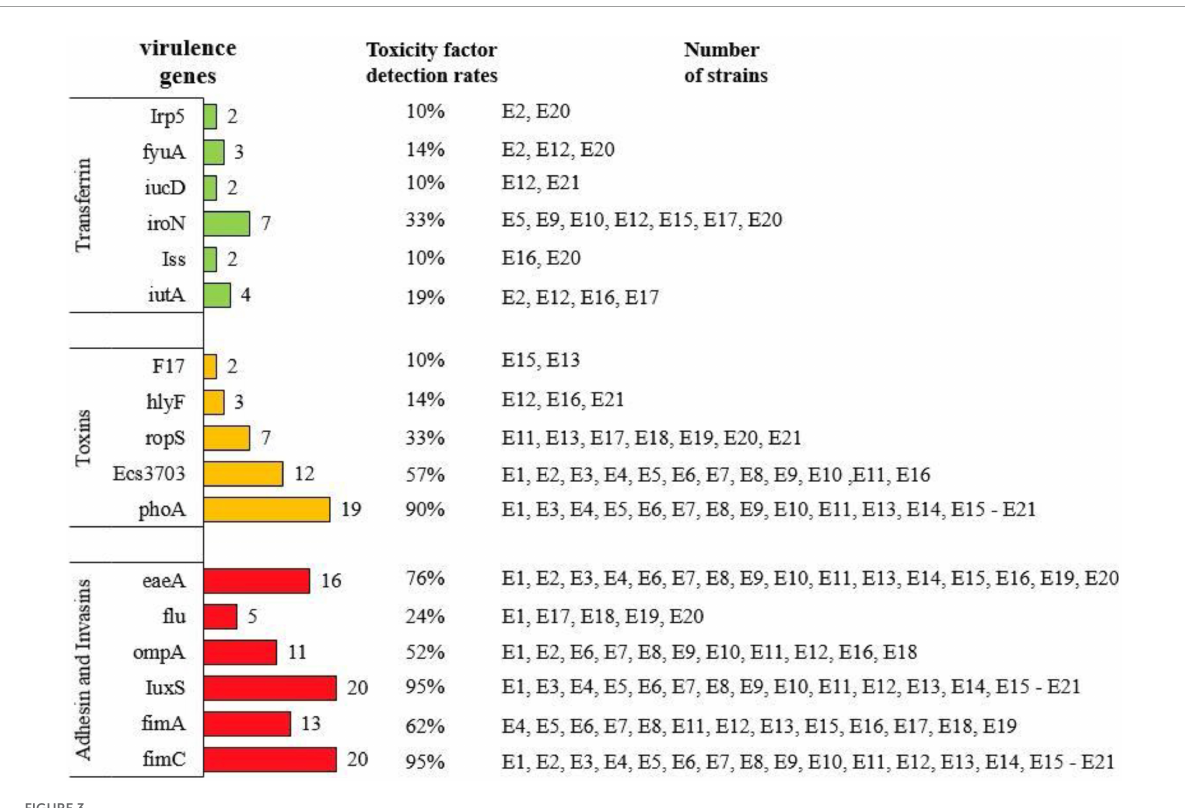
FIGURE3 Detection rate of diarrheagenic calves source Escherichia coli virulence